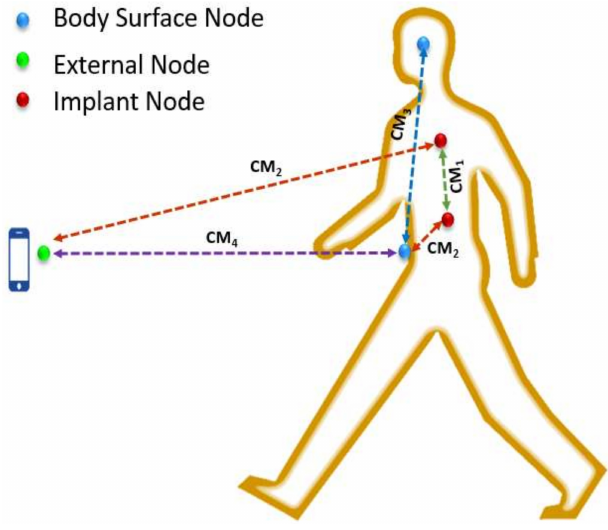
Figure 4. Possible communication links for WBAN. Table 3. List of scenarios and their descriptions of channel models for WBAN